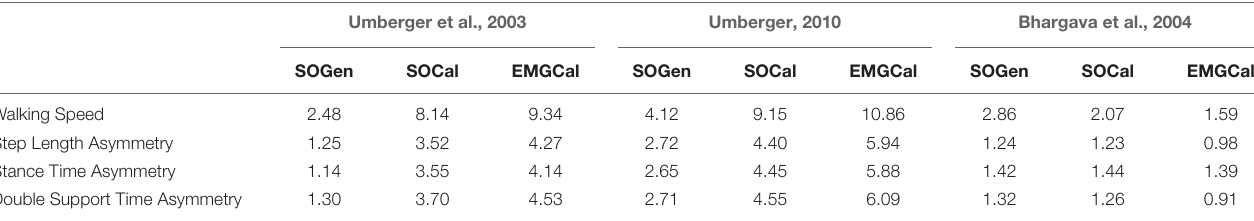
TABLE 4 | Absolute differences in regression line y-intercepts of CoT versus walking speed, step length asymmetry, stance time asymmetry, and double support time asymmetry between the nine model predictions and experimental measurements from Finley and Bastian (2017).